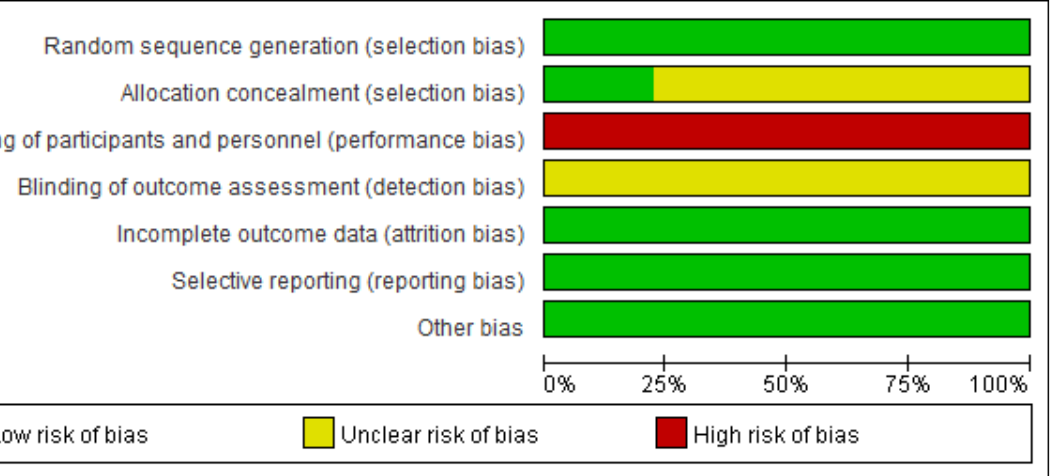
Figure 2. Review judgment of risk bias for each item: percentages across all included studies. Risk of bias levels: low (green or “+”), unclear (yellow or “?”), and high (red or “ − ”).